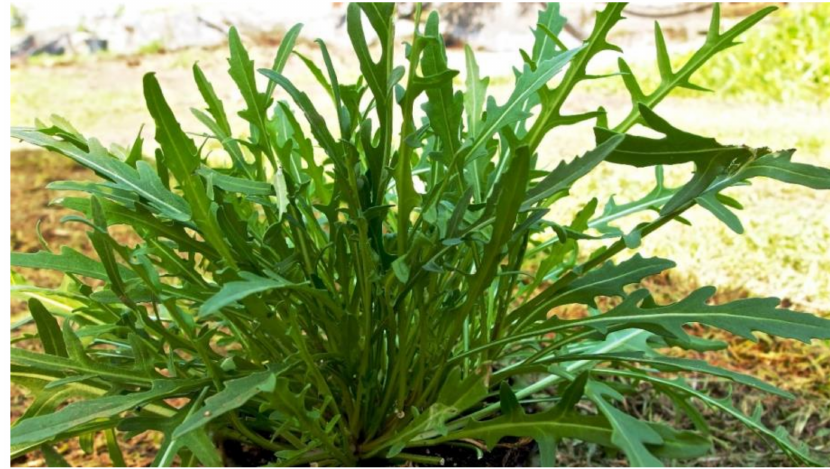
Figure 1. Perennial wall-rocket plant at the pre-harvest